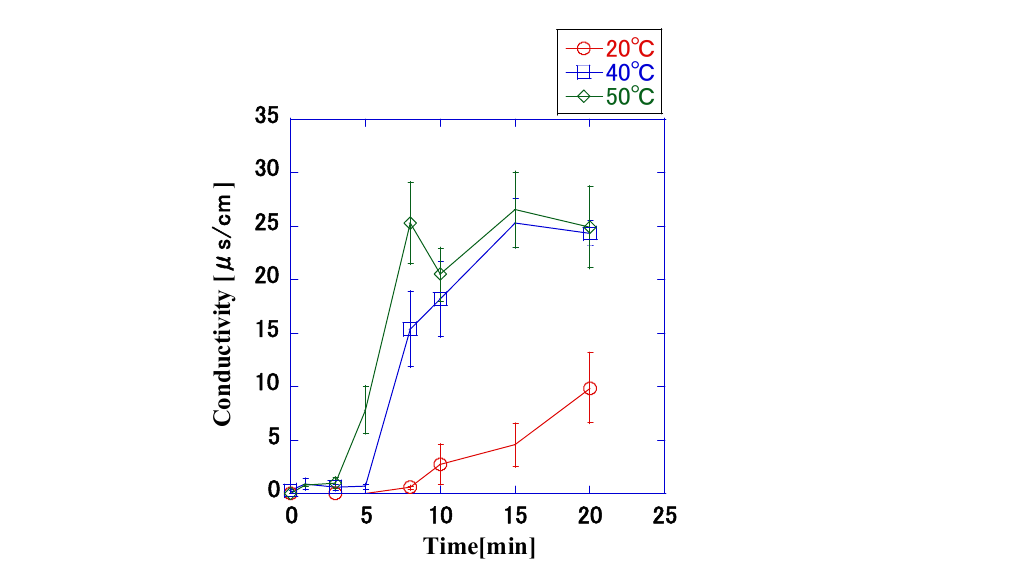
Figure 11. Variation in the electrical conductivity when the temperature of the bacterial suspension was controlled (8.0 × 10 9 CFU/mL, 7.5 kV, 6.9 µ s, 200 Hz). The conductivity increased as the temper- ature increased. Due to the detection limit of the conductivity meter, conductivity <0.01 µ s/cm could not be measured, and the conductivity was constant. There are no error bars at the detection limit.